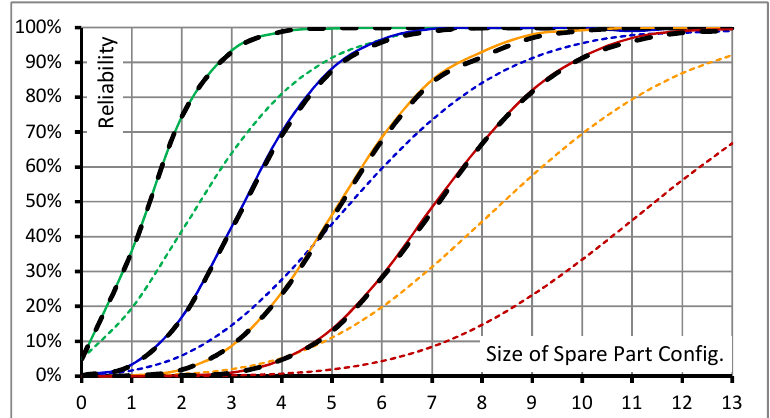
(𝑇|𝑁 ) for a very unreliable part. (cid:3036) (cid:3036)